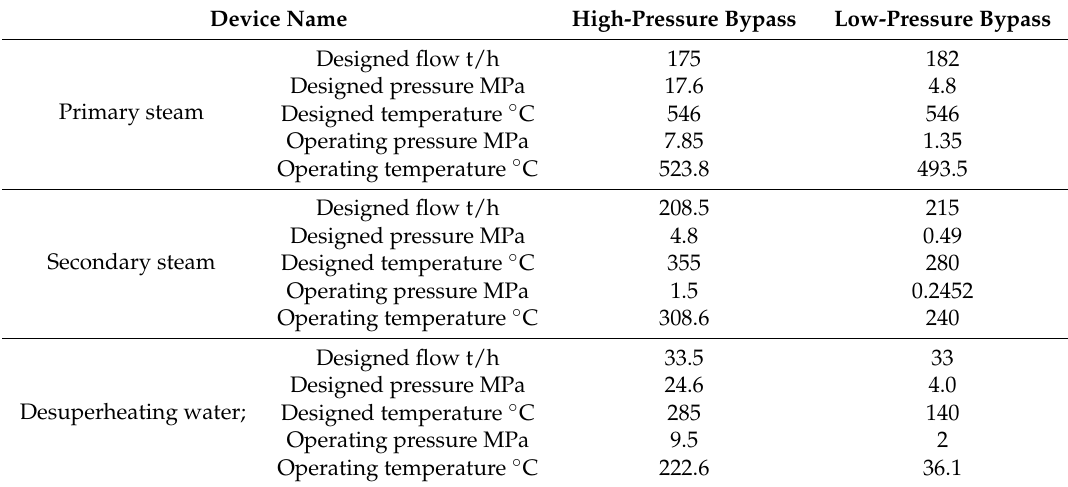
Table A2. Designed data of the two-stage bypass.